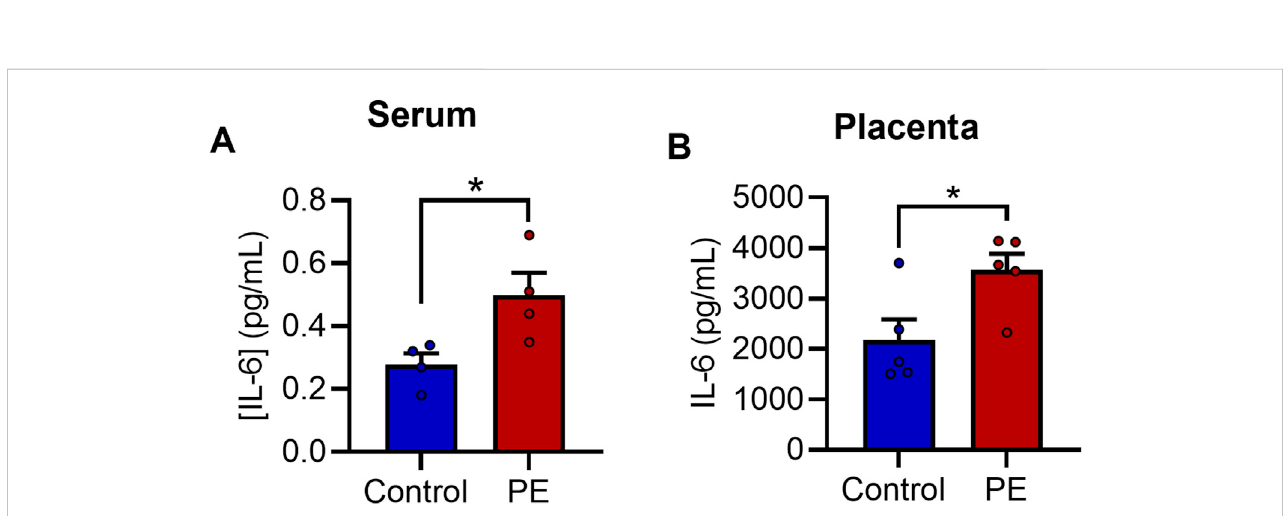
FIGURE 3 IL-6 is elevated in pre-eclampsia serum. Evaluation of [IL-6] in (A) maternal serum samples and (B) placental explant secretions. Data are mean +SEM from four samples per group for A and fi ve for B ( n = 4 – 5). (* p < 0.05 vs. control. Student ’ s unpaired t -test).